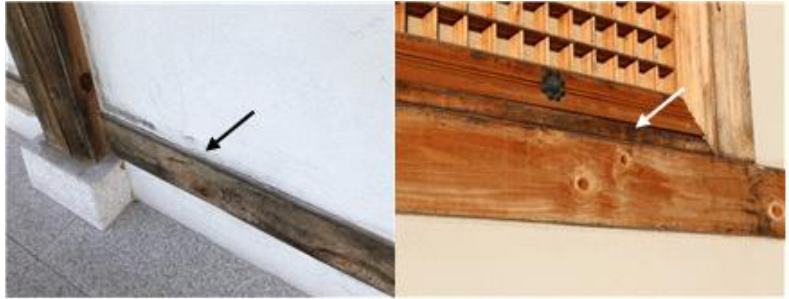
Figure 5. Hanok defects: fungal generation and discoloration.